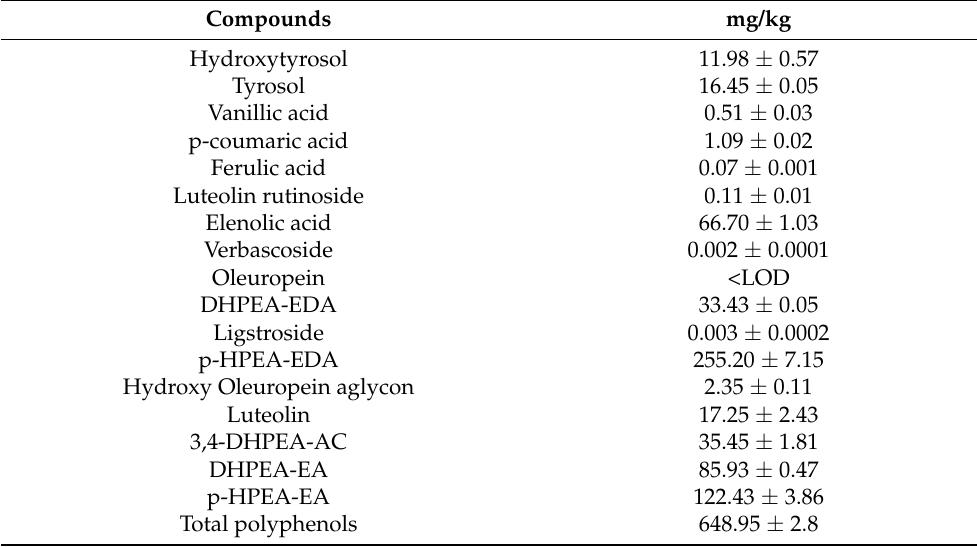
Table 3. Phenolic compounds profile of olive oil of cultivar “Oliva Bianca”. The parameters are expressed as media of three different replicates ± SD (LOD =